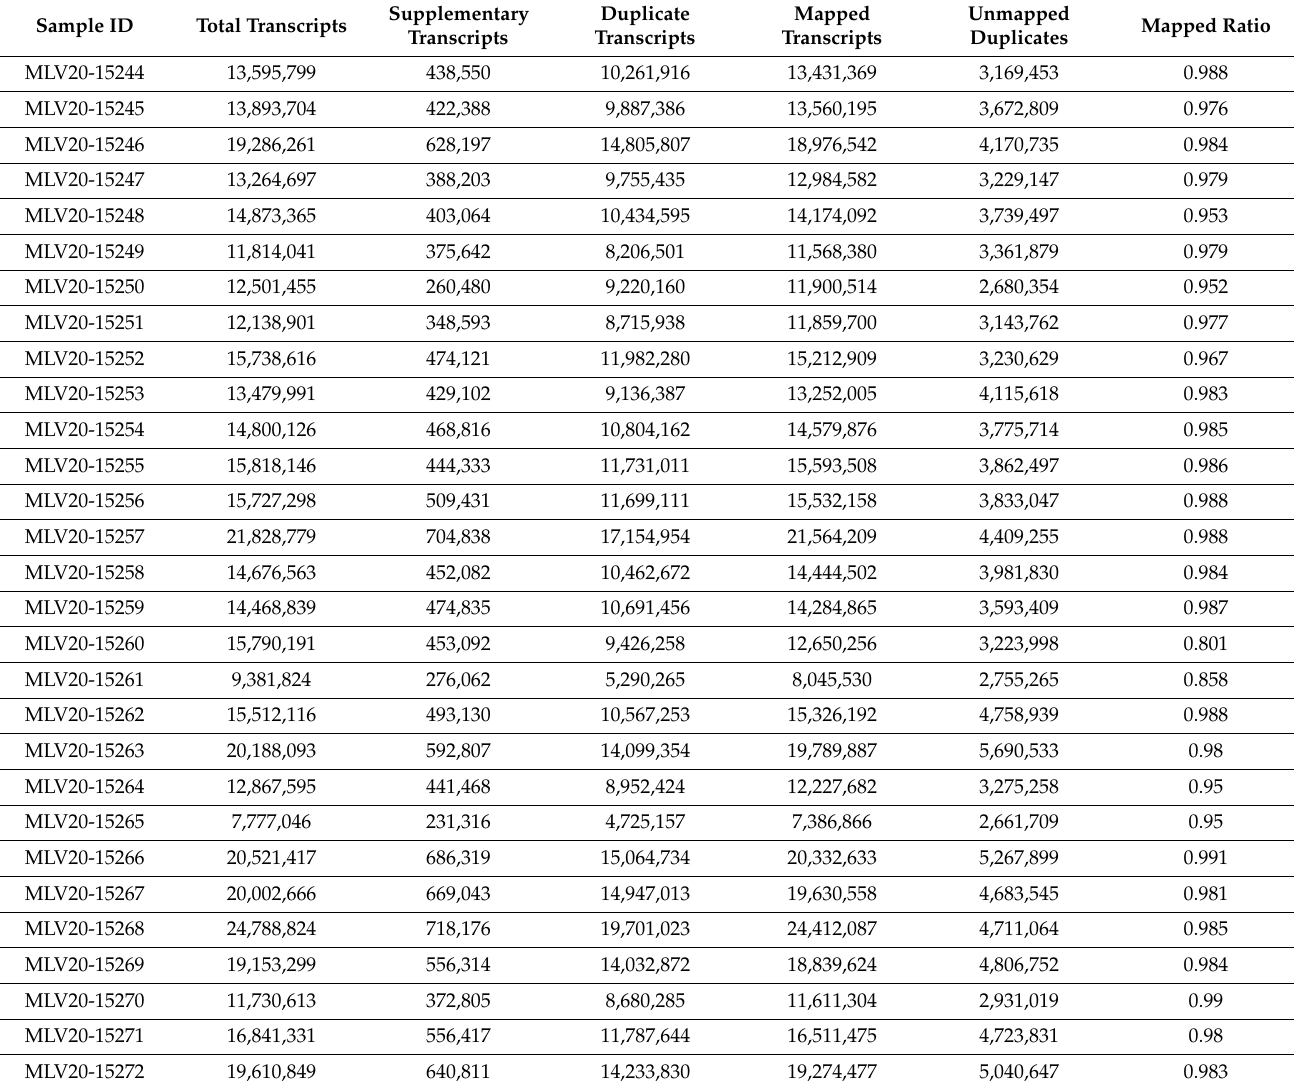
Table 1. Mapping statistics against the supertranscript. Mapping of each specimen’s transcript profile used as reference the supertranscript and the GATK4 protocol. The total number of sequences per sample, mapped sequences, duplicates and purified sequences in the refinement of the protocol are shown in this table. For details on the sampling information of each specimen please refer to Materials and